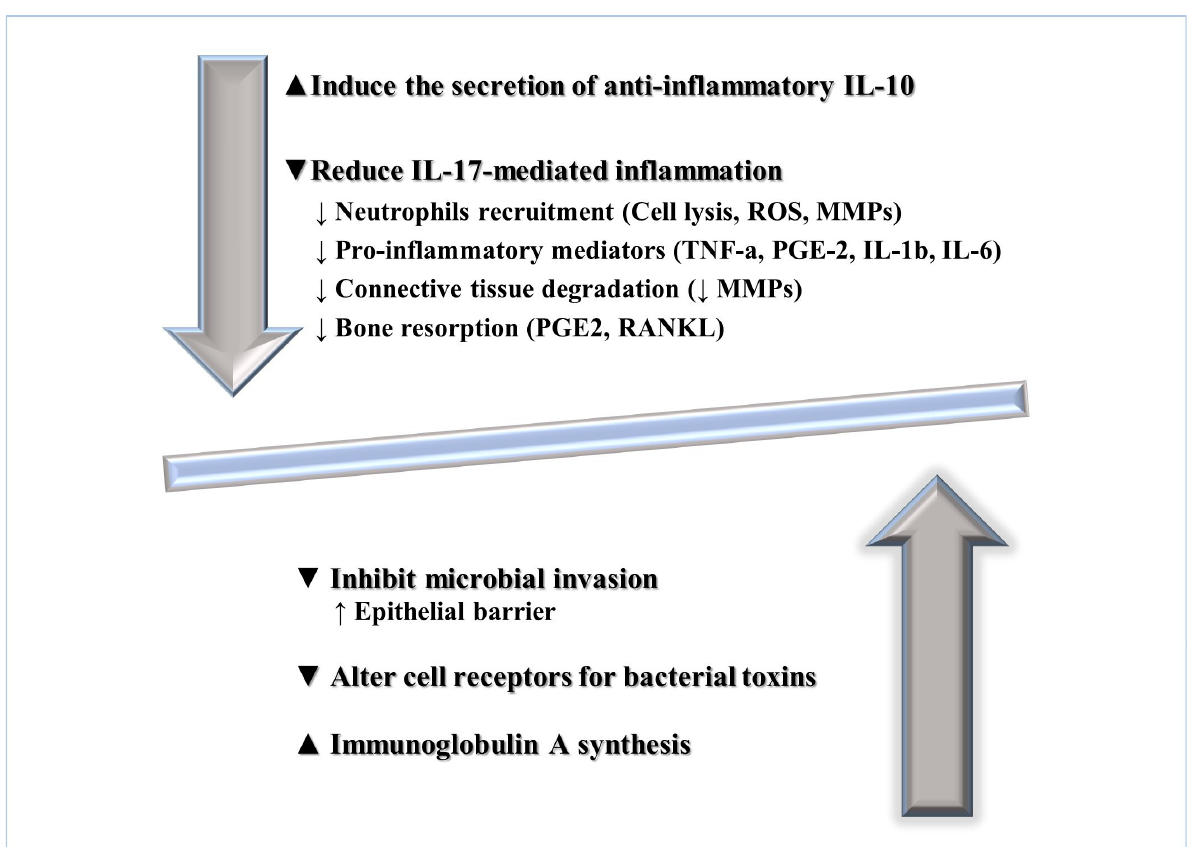
Figure 2. Putative probiotics’ effects on host modulation in periodontal and peri-implant tissues. Abbreviations: IL-10, Interleukin-10; ROS, reactive oxygen species; MMPs, matrix metalloproteinases; TNF-a, tumor necrosis factor-alfa; PGE-2, Prostaglandin-2; RANKL, Receptor Activator of Nuclear Factor κ B Ligand.